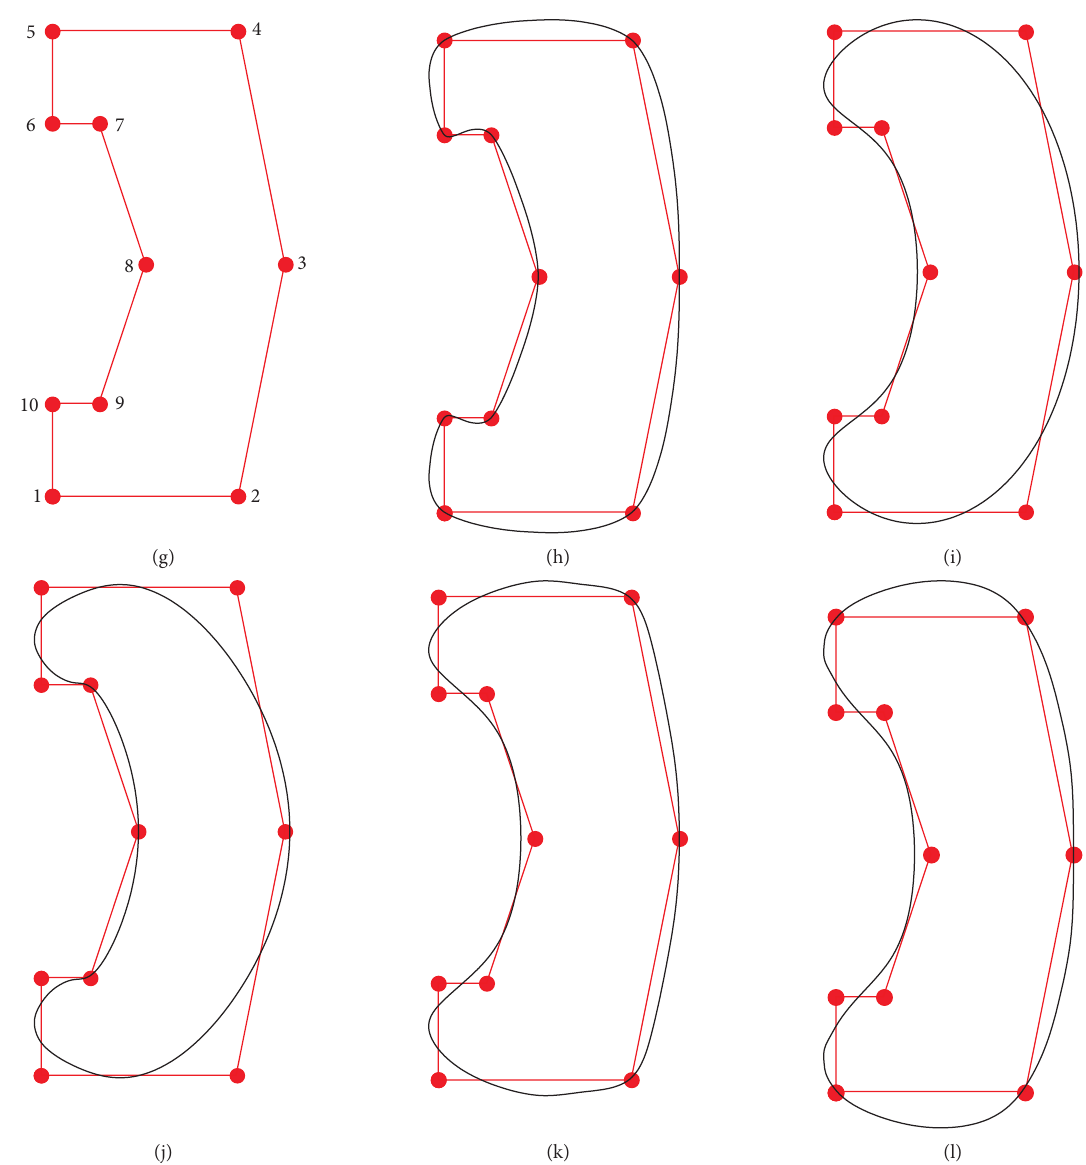
Figure 10: The effect of local interpolation by our combined subdivision scheme S with different α i and β i is shown in (g–l), combined subdivision scheme S a 5